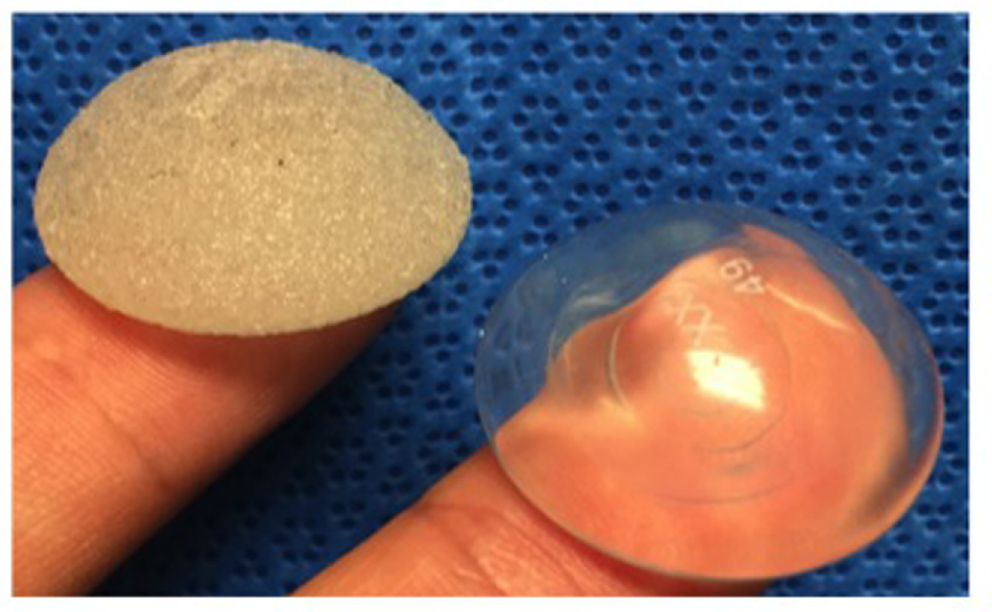
Fig 1. Gel-filled textured (left) and smooth (right) silicone implants (Polytech Health and Aesthetic, Dieburg, Germany).